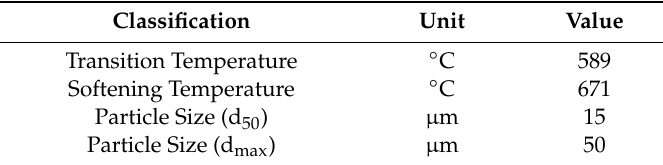
Table 1. Thermal properties and particle sizes of developed glass.